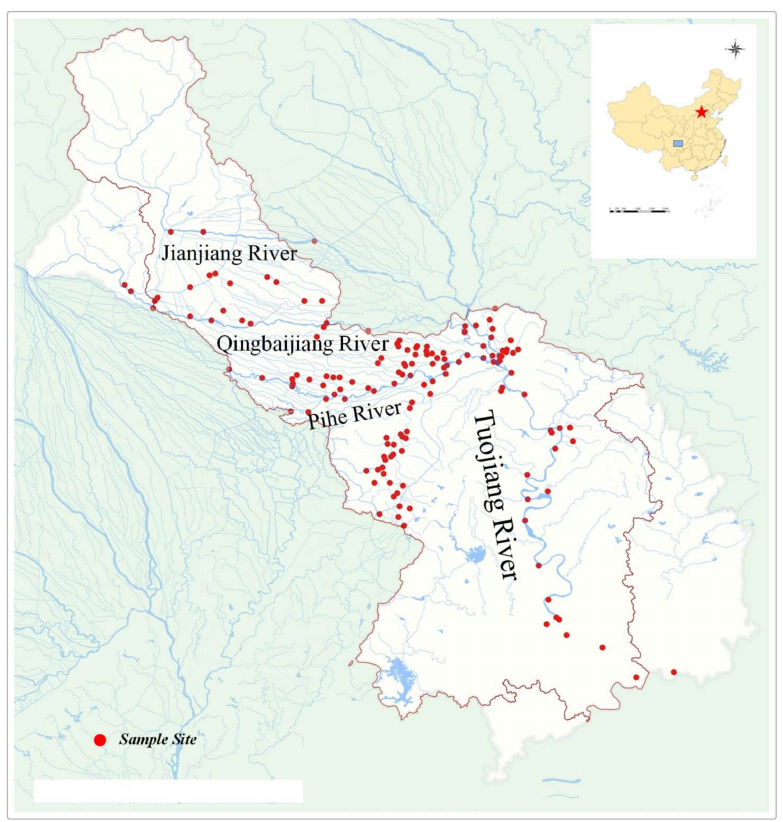
Figure 1. The map of river systems and sample